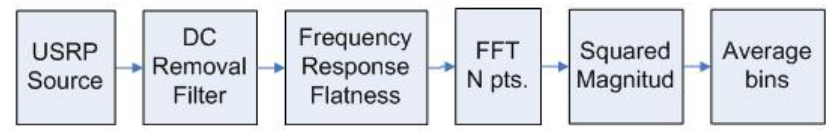
Figure 4. SSM, block